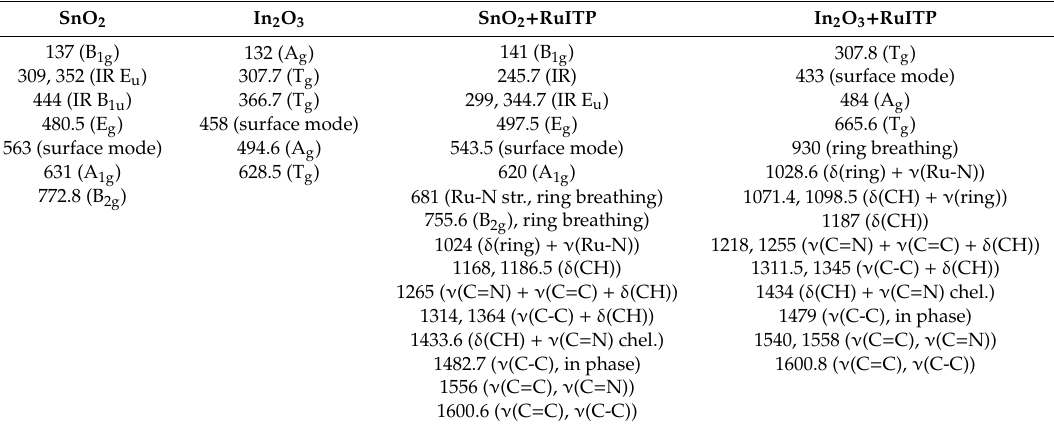
Table 2. Assignment of Raman vibrational modes (cm − 1 ).